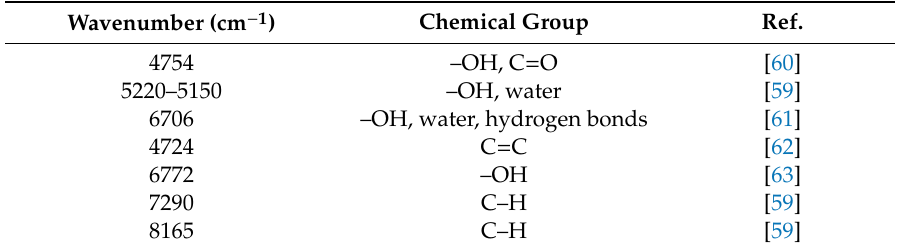
Table 5. Tabularized absorption bands assigned to the chemical